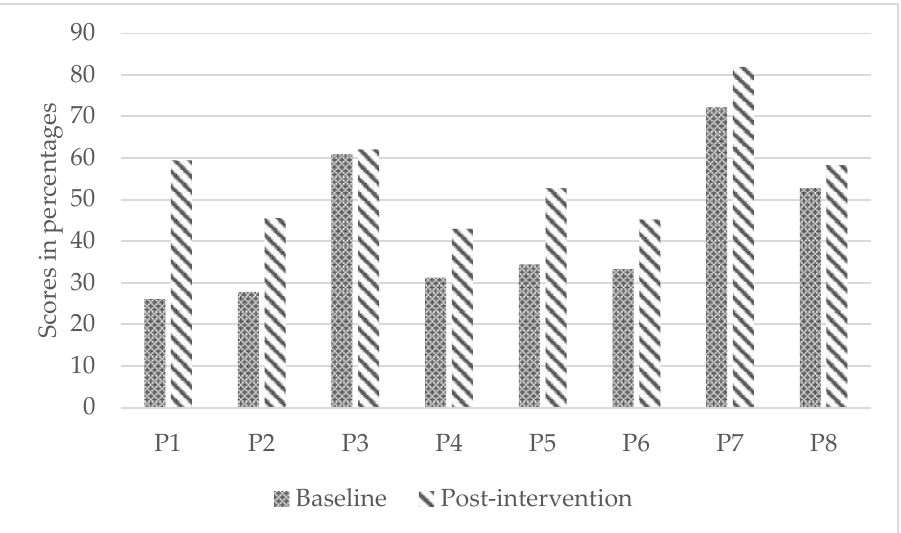
Figure 2. Individual improvements in wheelchair skills capacity from baseline to post-intervention.